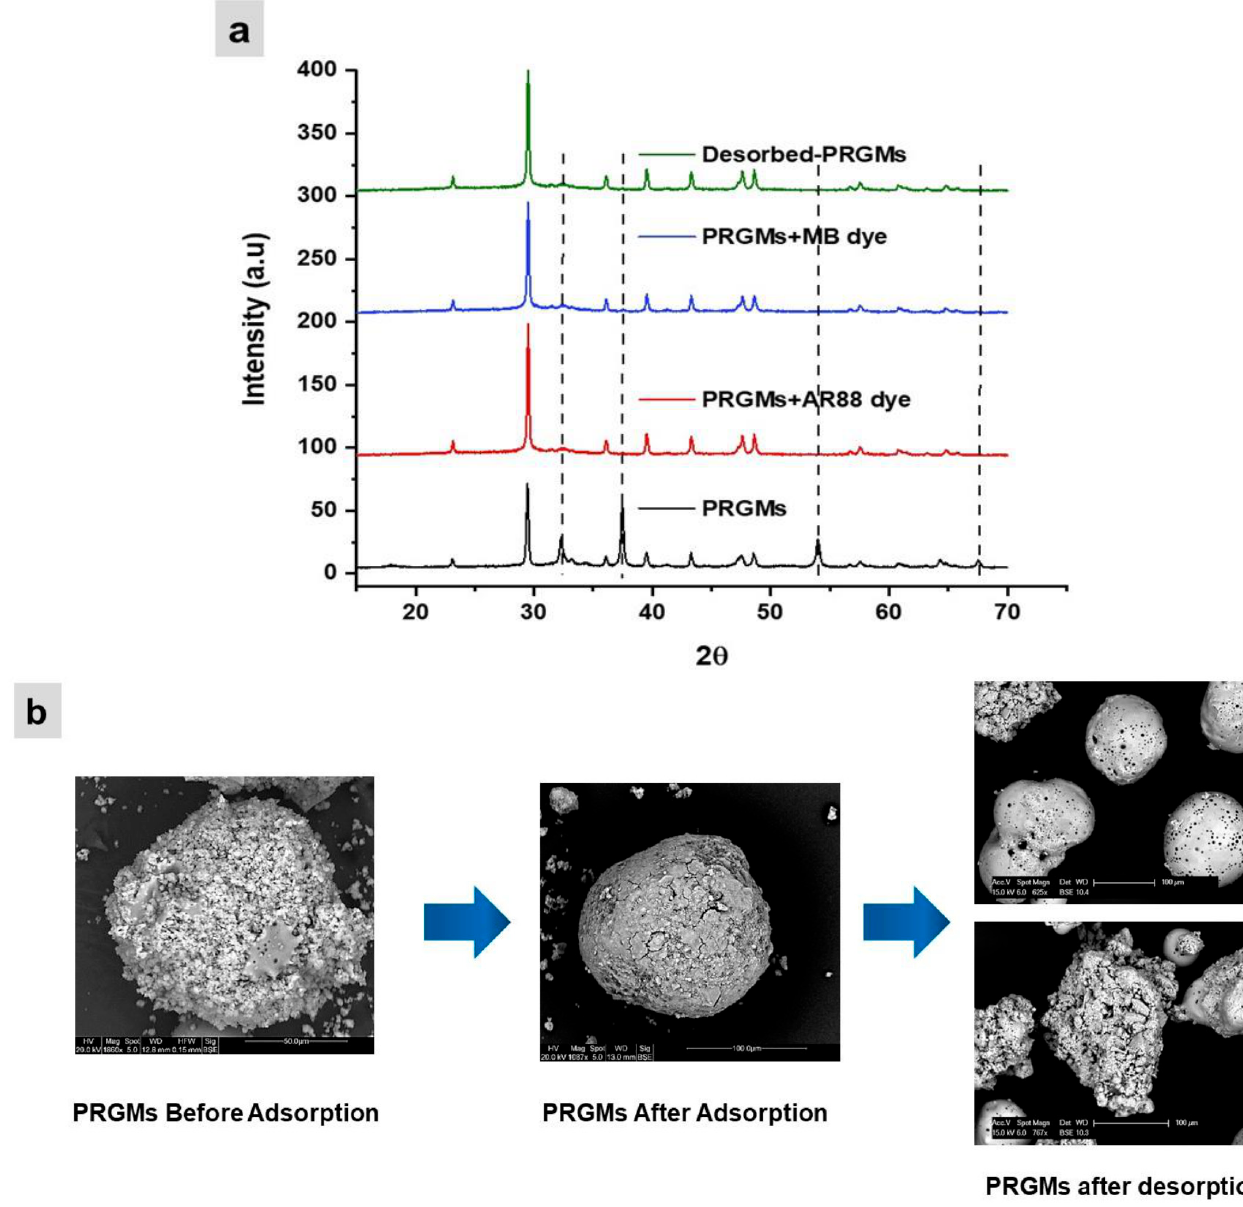
Figure 11. The XRD patterns ( a ) and SEM images ( b ) of PRGMs before dye adsorption, after dye adsorption and desorption.